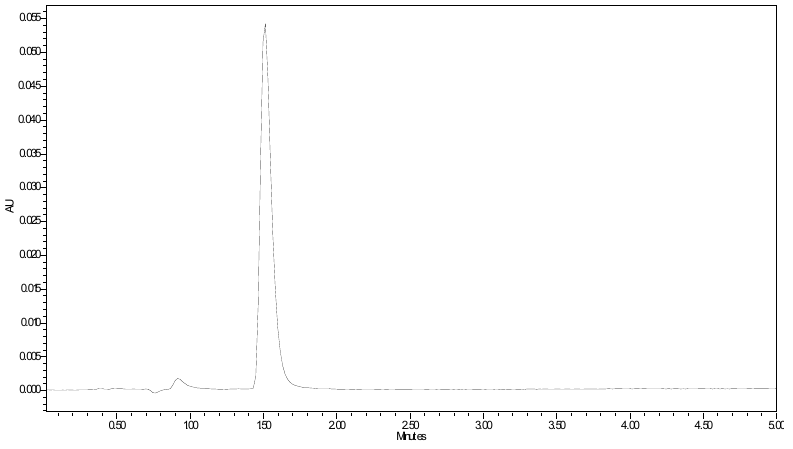
Figure 7. HPLC-DAD imidazole chromatogram at λ = 215 nm. Table 1. HPLC-DAD imidazole linearity data. All concentrations are in µ g/g. RSD, relative standard deviation. When applicable, values are presented as mean values ± standard